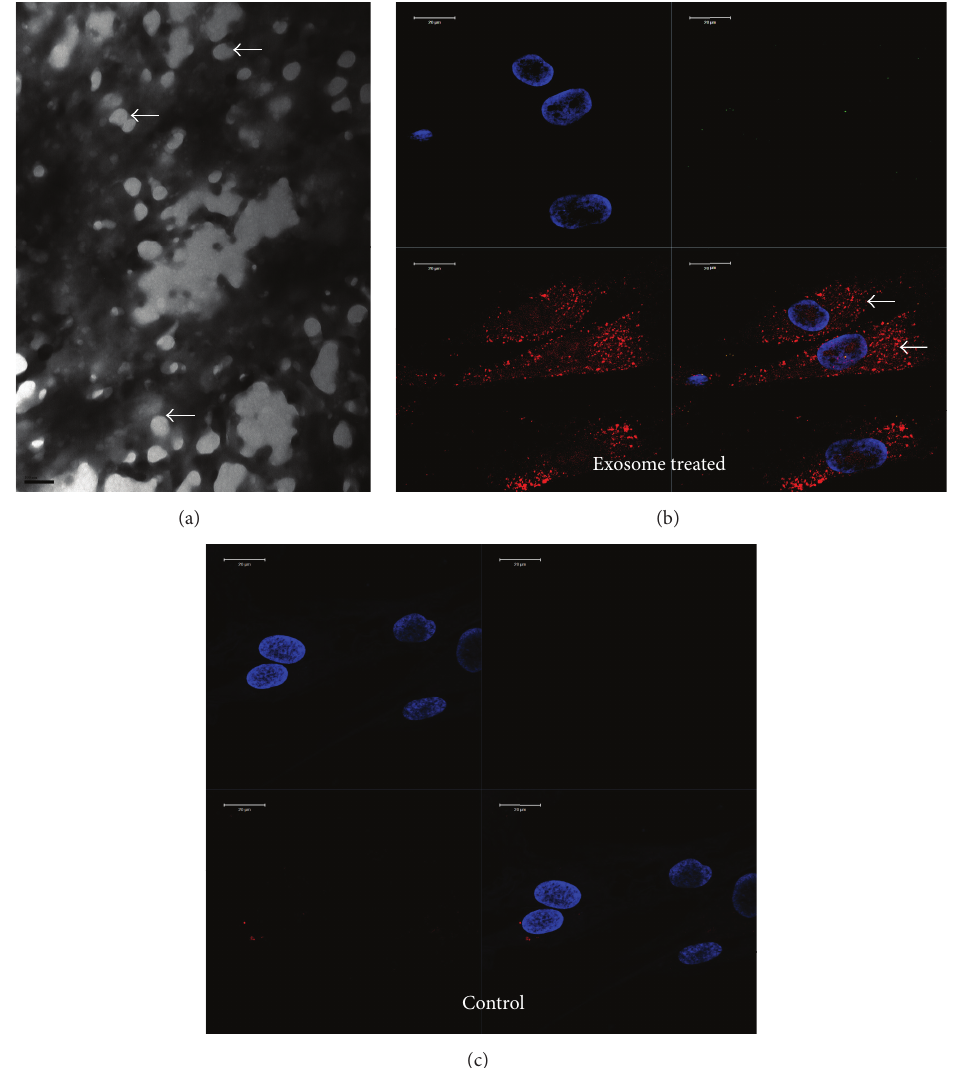
Figure1:Generationandendocytosisofexosomes:(a)arepresentativeTEMimageshowingthepresenceofexosomesinourpurifiedsamples. Scale bar represents 100 nm. The white arrows in the image point to exosomes. The grids were stained with phosphotungstic acid and hence the background is black. (b) Representative confocal micrograph showing the presence of endocytosed exosomes. White arrows point to the endocytosed exosomes. (c) Confocal micrograph showing the absence of exosomes or nonspecific presence of labeling dye. The scale bar in the confocal micrographs represents 20 𝜇